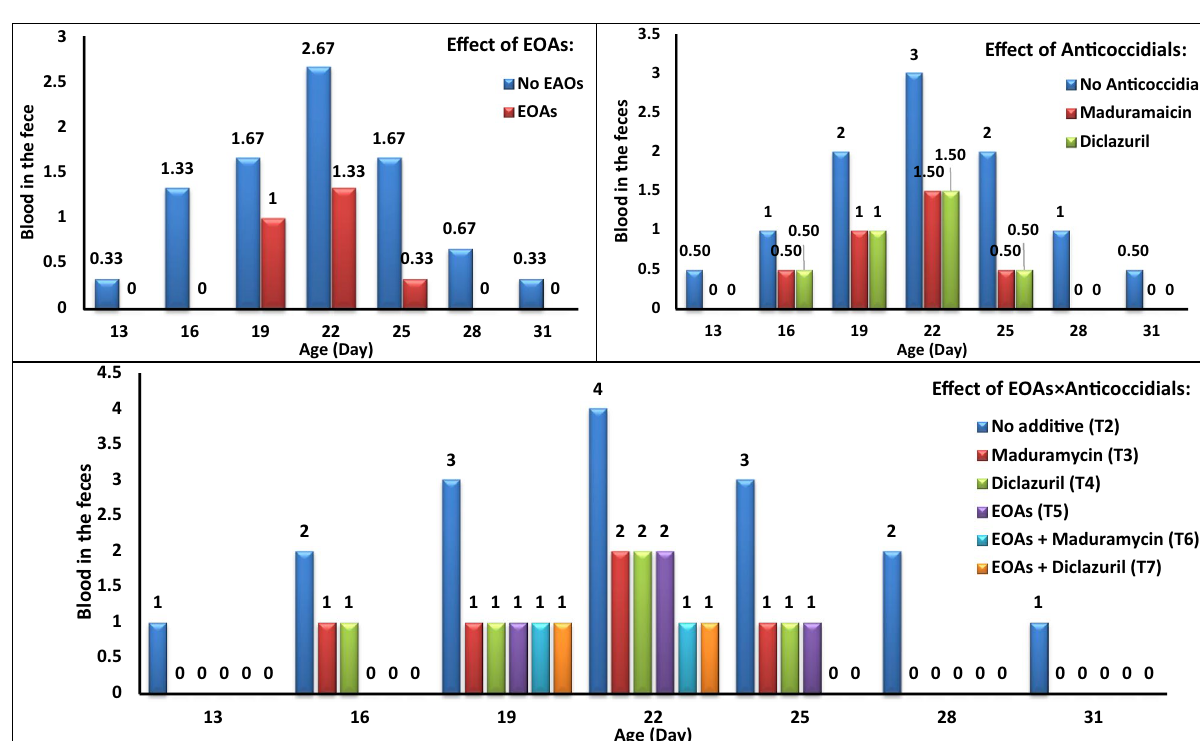
Figure 1. Effect of EOAs and anticoccidials on blood in the feces of broilers infected with